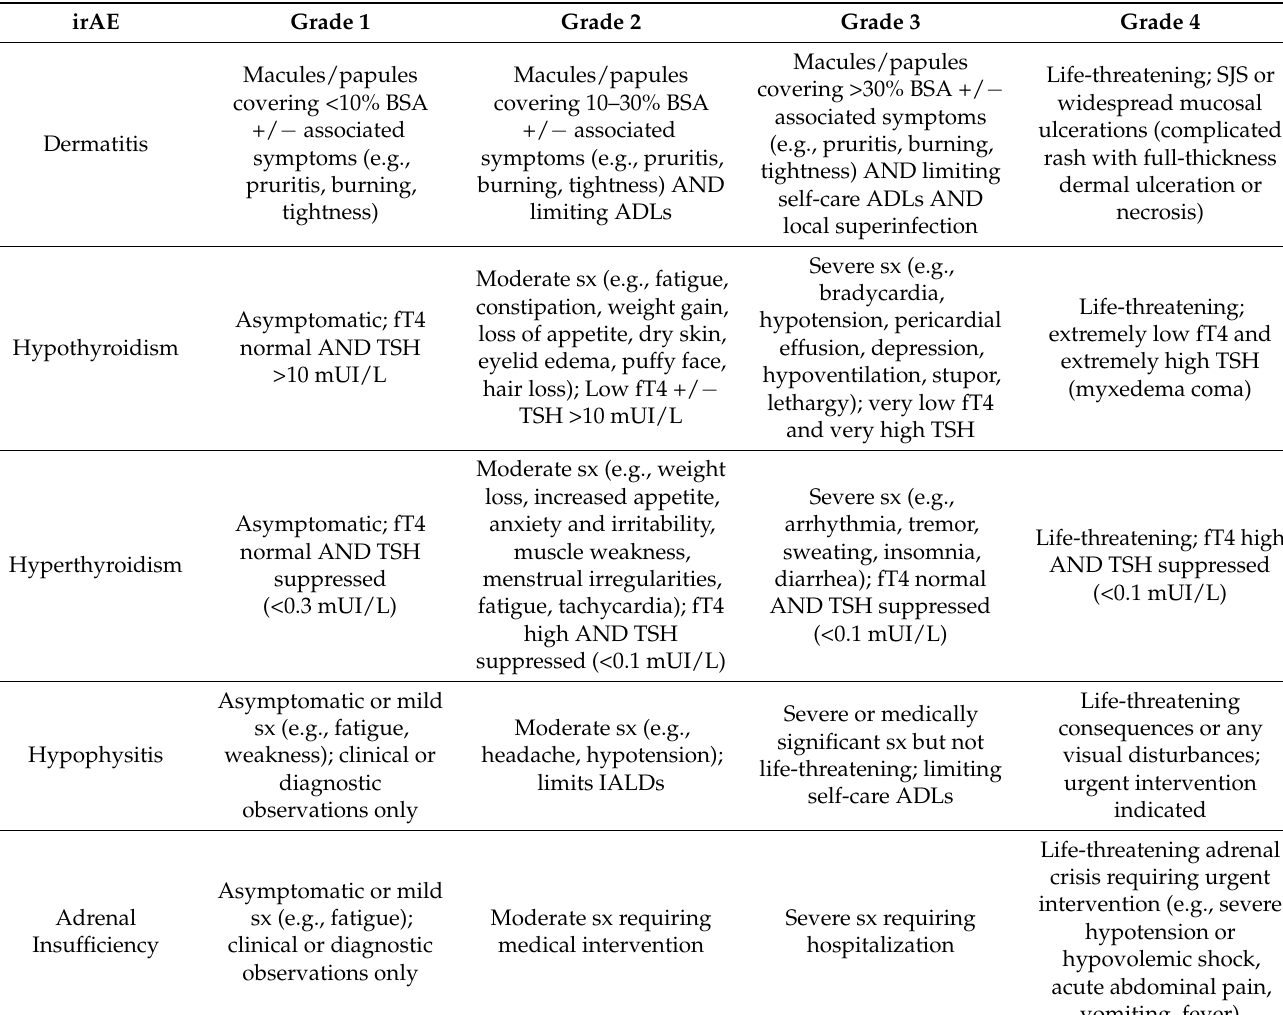
Table 2. Definition of grades of severity for various common irAEs. These definitions have been taken from the CCO Immune Checkpoint Inhibitor Management Clinical Practice Guidelines